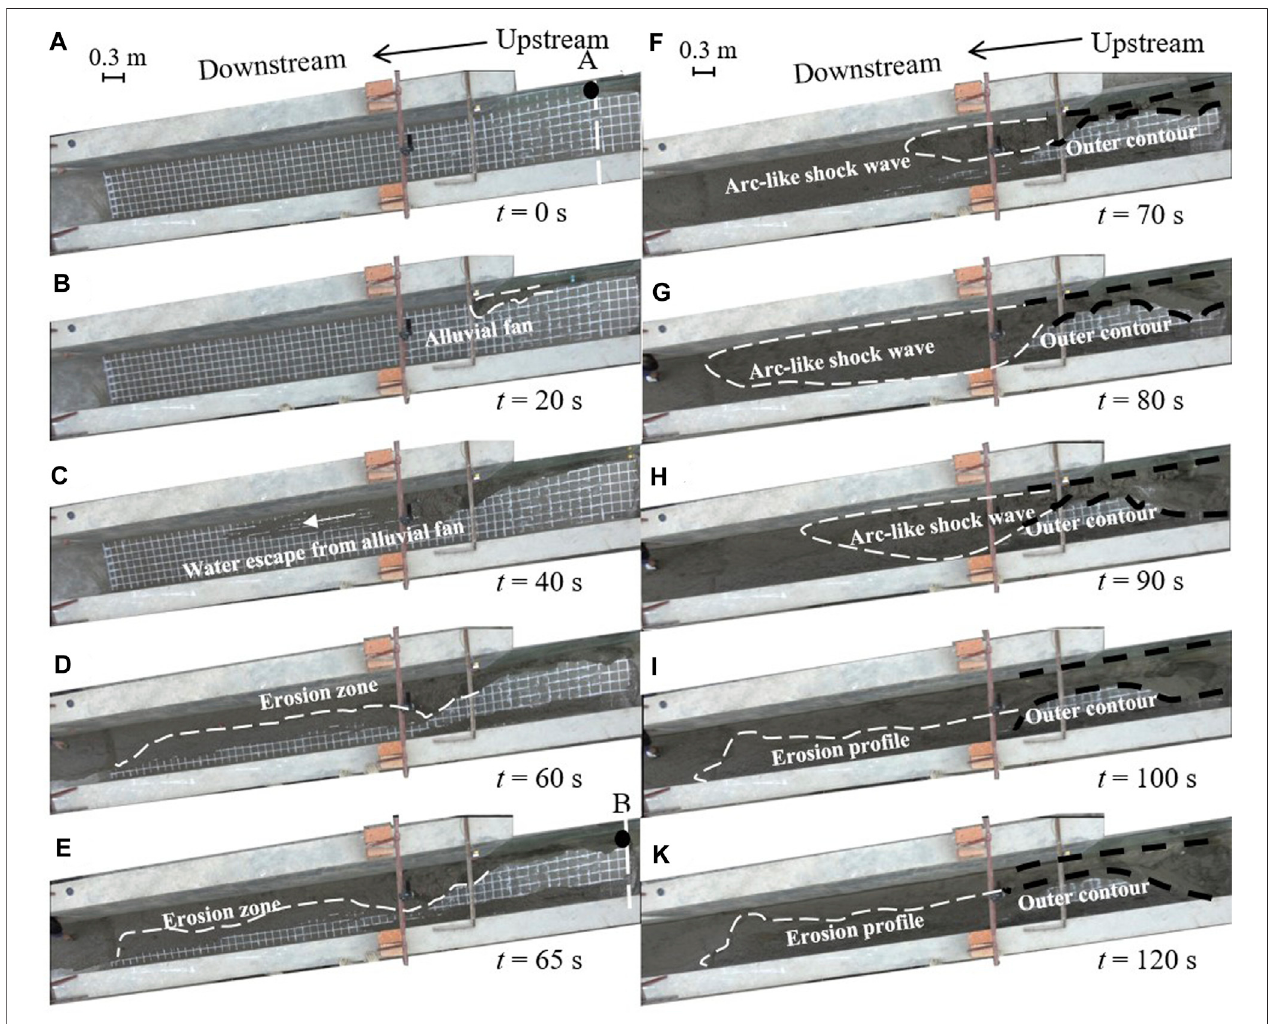
FIGURE 4 | Snapshots of the dam-breaching process (Test No. E-Q3.0). t 0 (cid:2) 0 s is the moment when water starts to travel along the initial notch and eventually reaches the downstream crest. The grid is 0.1 m × 0.1 m. The dashed lines mark the surface pro fi le of the dam geometry.